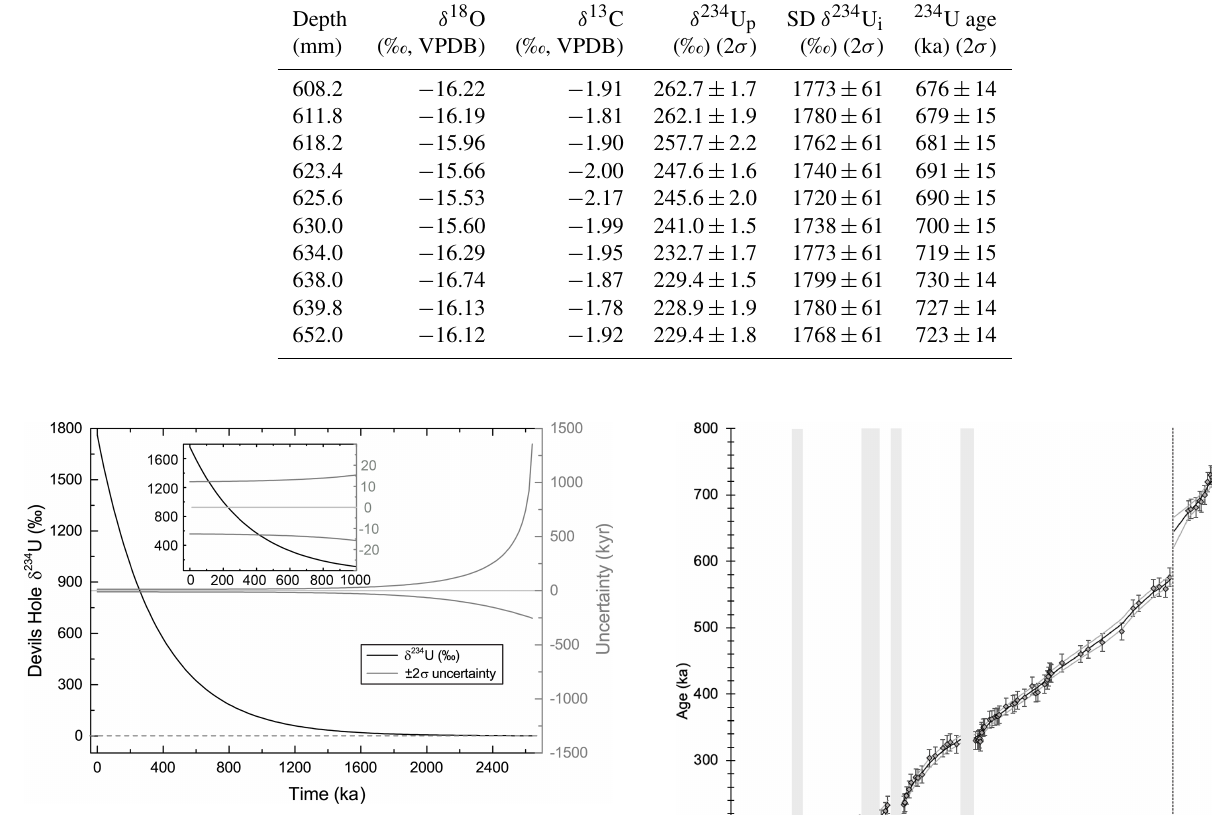
Figure 4. Evolution of δ 234 U (black line) and corresponding uncer- tainties of 234 U ages (grey lines) with time. The insert plot shows the δ 234 U evolution during the period of 0–1Ma. The dashed grey line indicates where δ 234 U is 0.